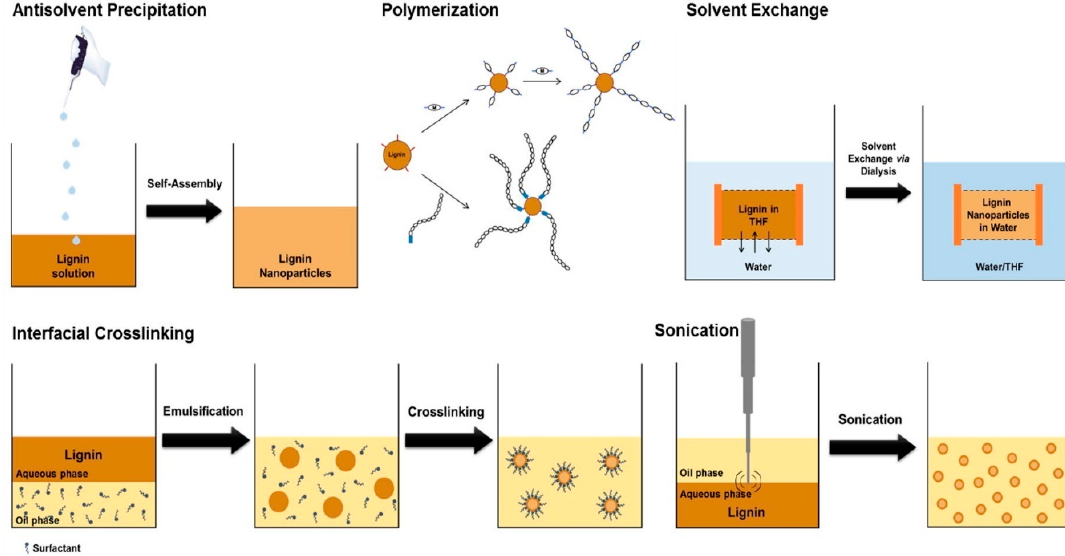
Figure 12. Schematic representation of the different methodologies used to produce lignin nanoparticles. Reprinted from [120] with permission from Elsevier © 2020.